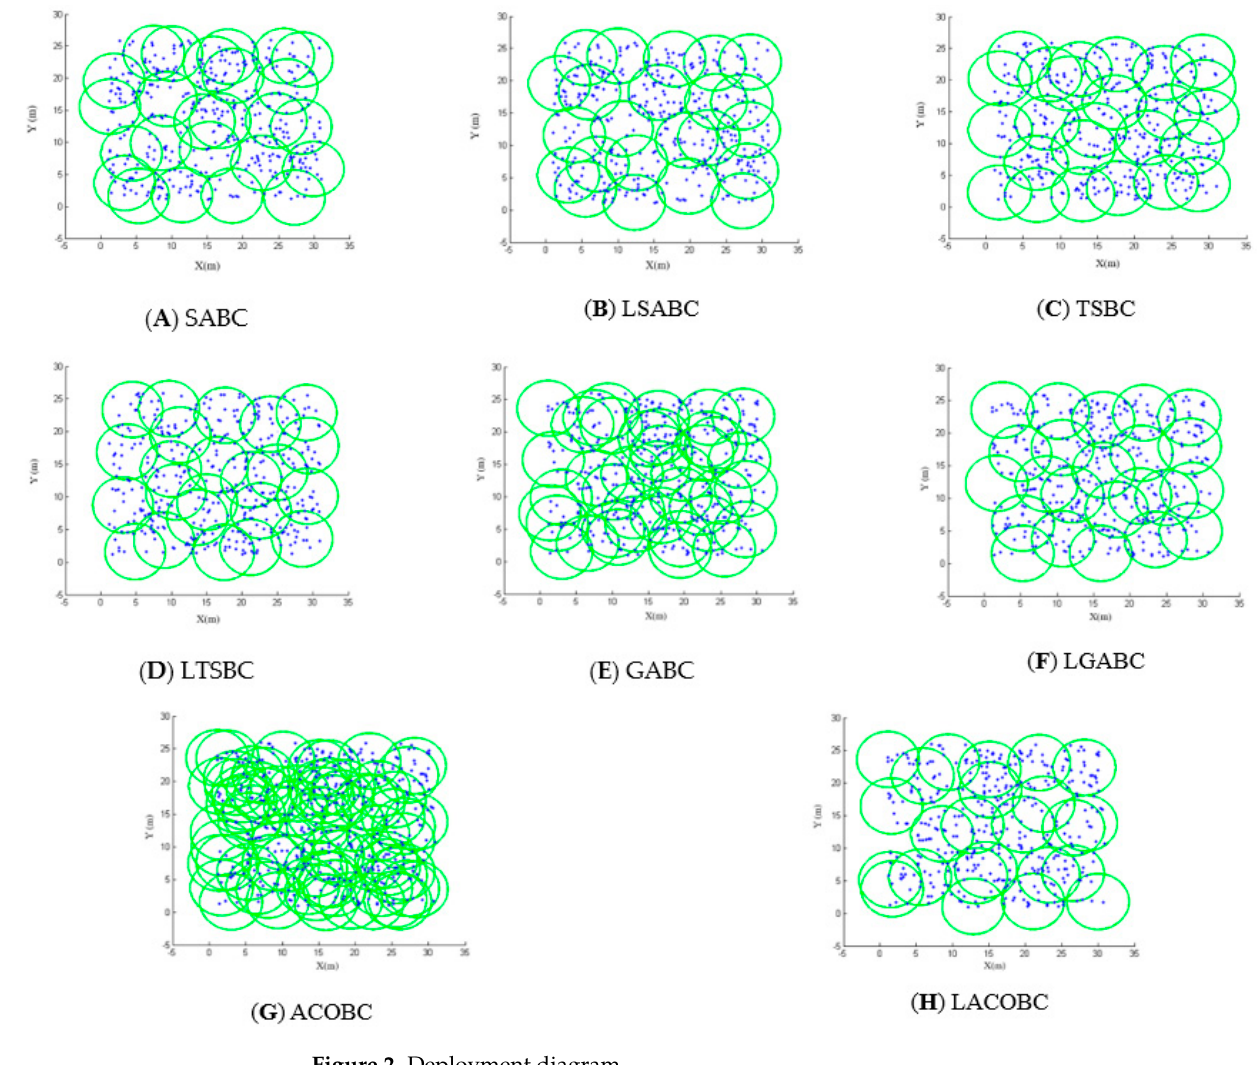
Figure 2. Deployment diagram.